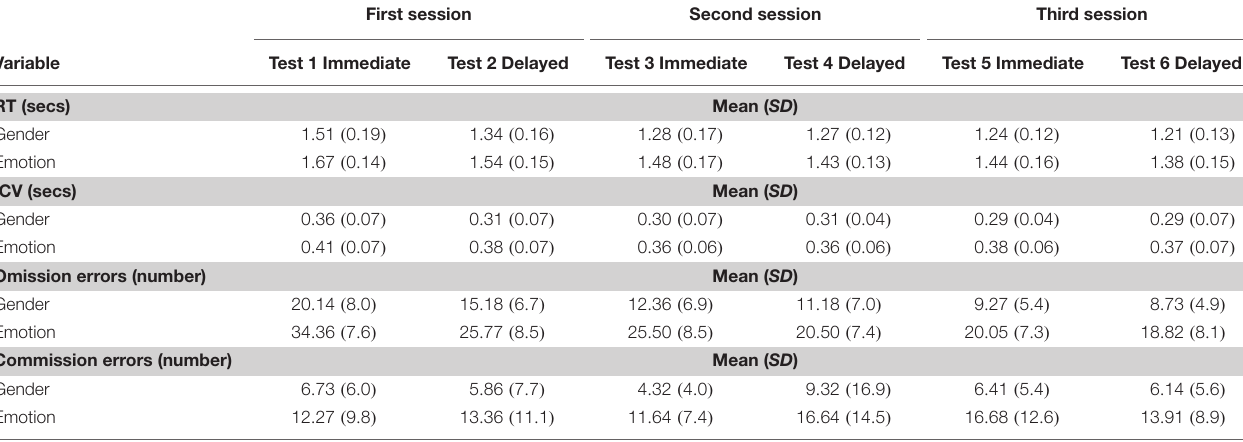
TABLE 1 | Means and Standard deviations for each dependent variable for first, second and third session (order